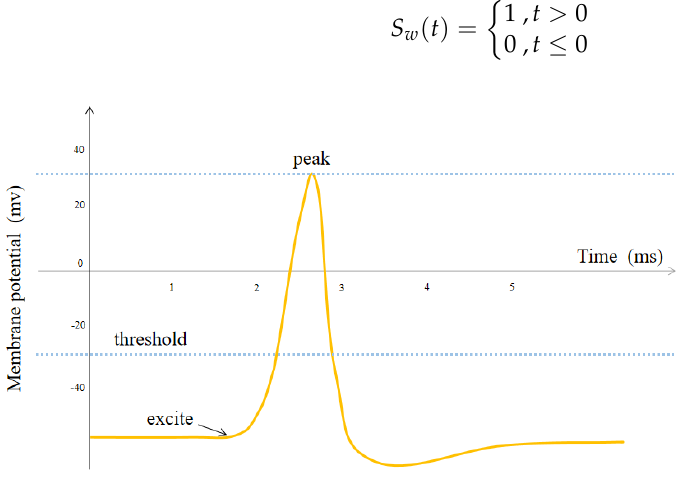
Figure 4. Single-neuron excitation model.